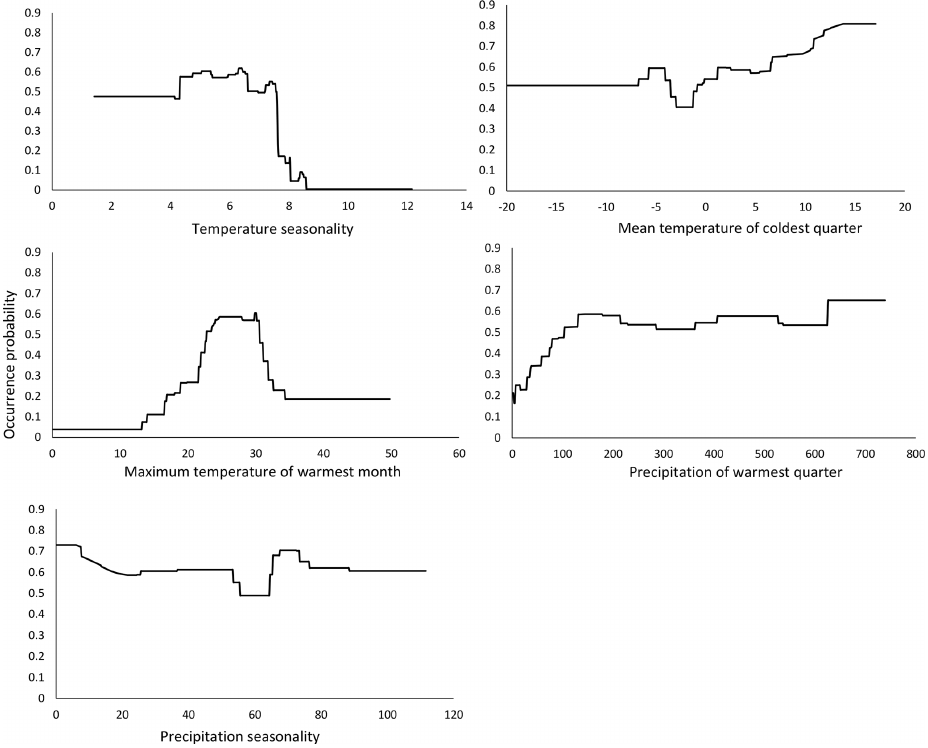
Figure 3. Response curves of the predictor variables of temperature seasonality, mean temperature of coldest quarter, max temperature of warmest month, precipitation of warmest quarter and precipitation seasonality, as functions of the occurrence probability in the model that predicts the actual potential distribution (Fig.